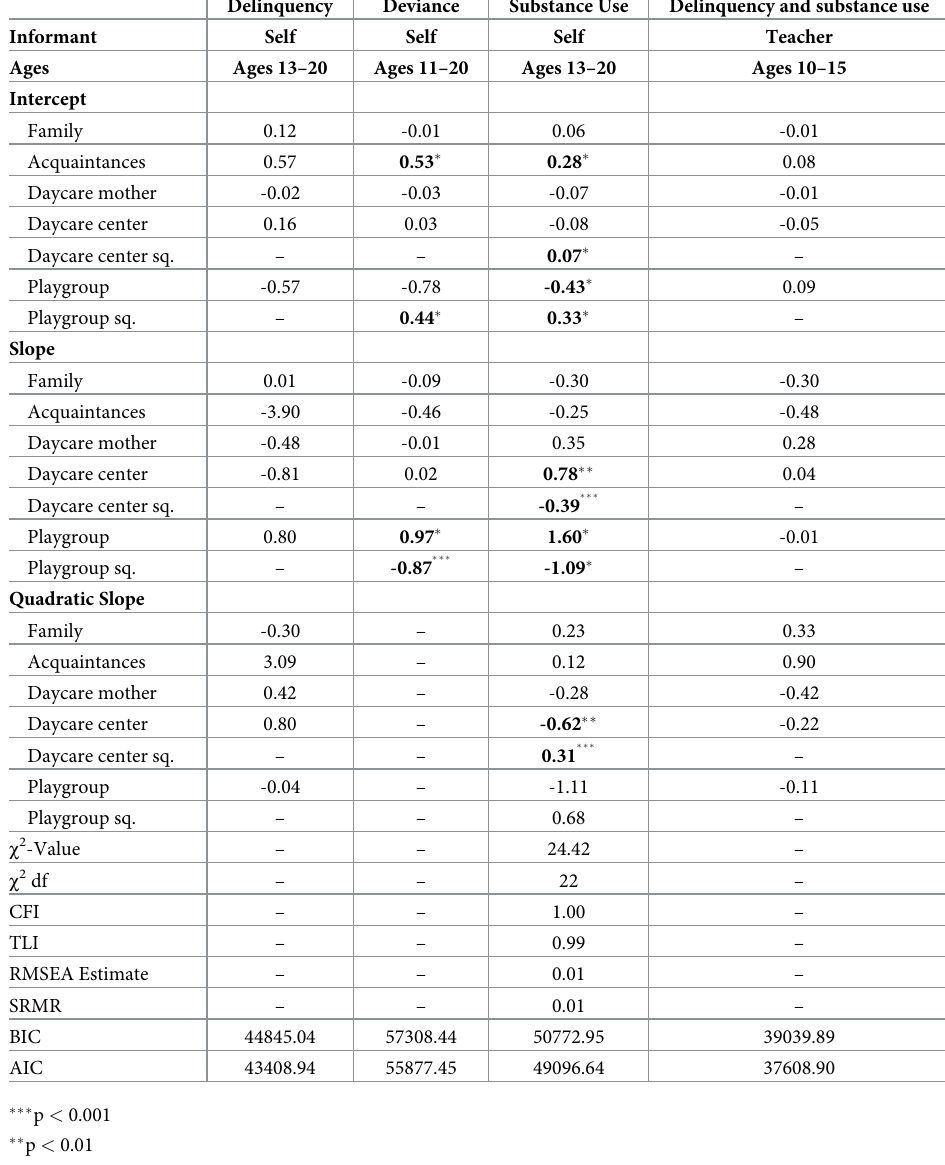
Table 5. Associations between external childcare, delinquency, and substance use. Unstandardized coefficients from growth curve